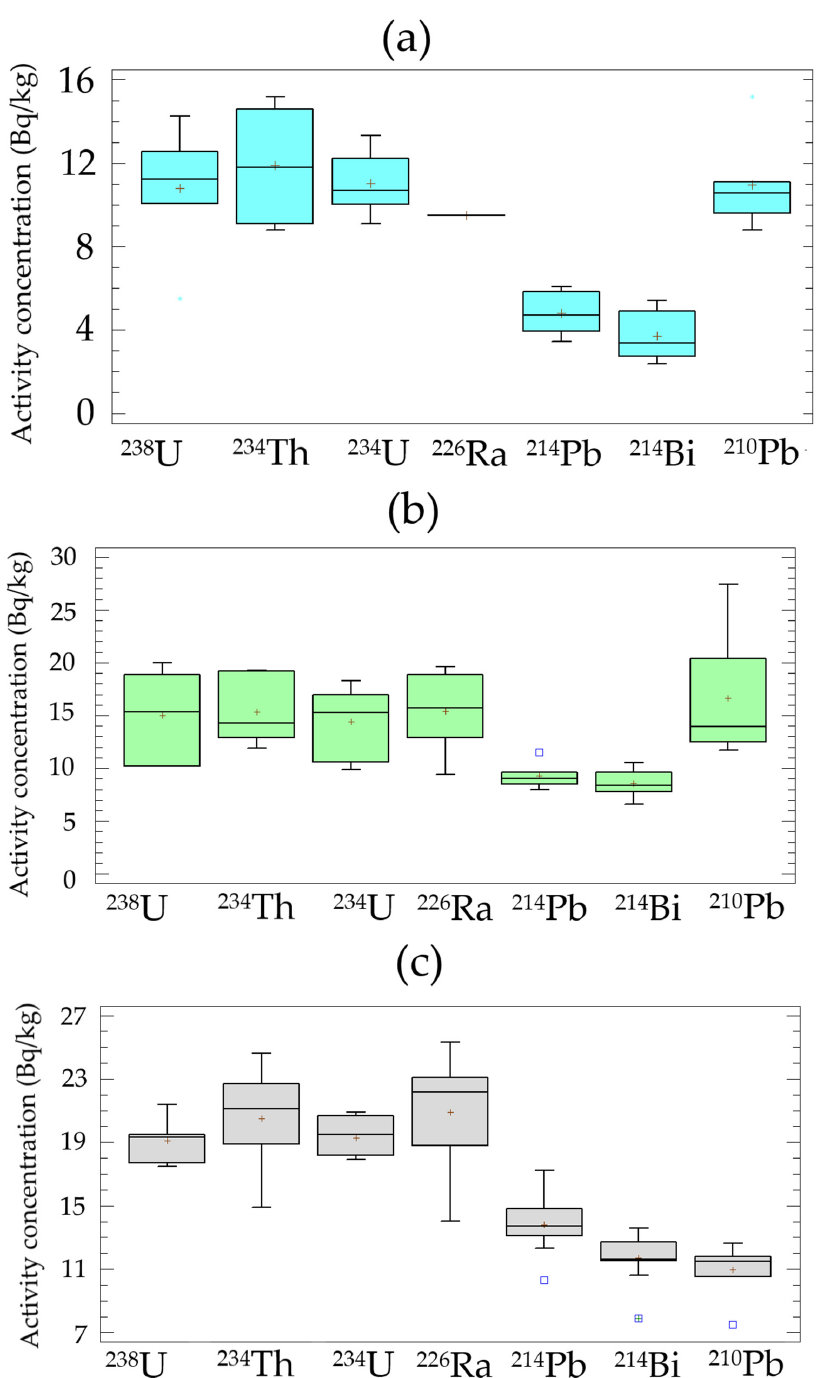
Figure 4. Distributions of the activity concentrations of 238 U, 234 Th, 234 U, 226 Ra, 214 Pb, 214 Bi, and 210 Pb: ( a ) mortar made with CEM I 52.5 R-SR 3 cement, ( b ) mortar made with CEM II/A-S 42.5 N cement, and ( c ) mortar made with CEM III/A 42.5 N cement.